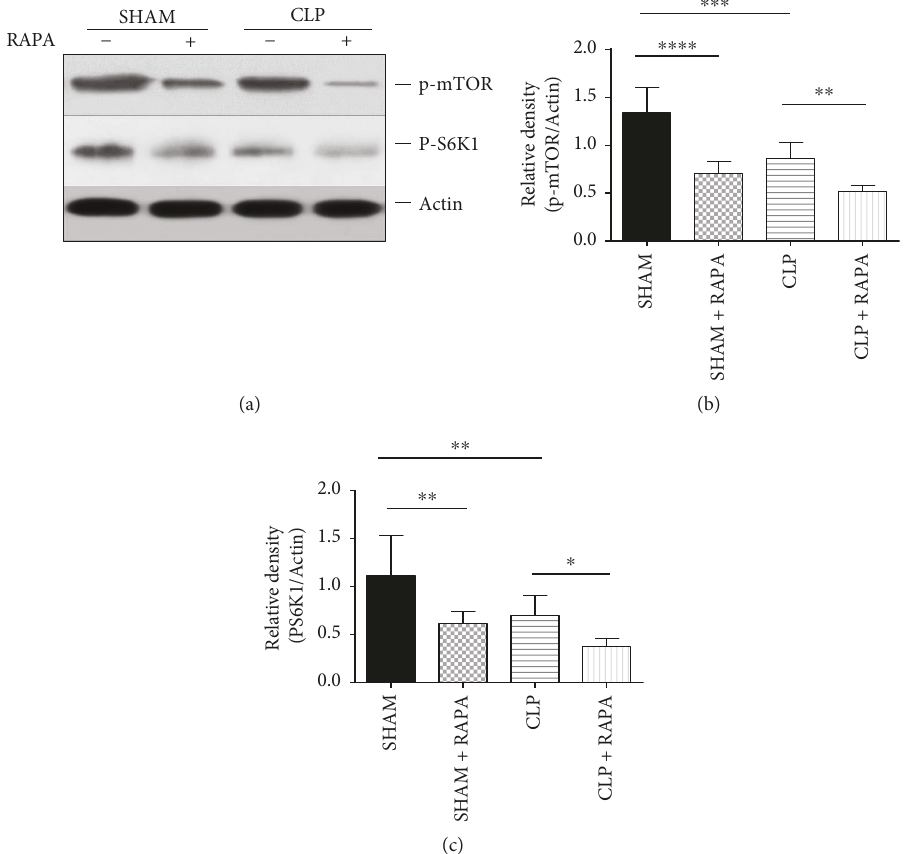
Figure 4: p-mTOR and PS6K1 expression in the left ventricle. The left ventricle was harvested 18h after CLP, and p-mTOR and PS6K1 protein levels were quanti fi ed by western blotting. Mean ± SD, six rats per group, ∗ p < 0 05 ; ∗∗ p < 0 01 ; ∗∗∗ p < 0 001 ; ∗∗∗∗ p < 0 0001